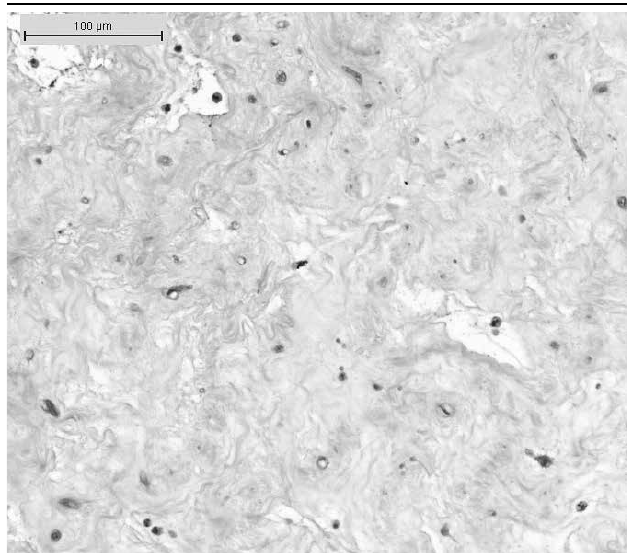
figurE 2 − Histological section of umbilical cord showing normal appearance of Wharton’s jelly.